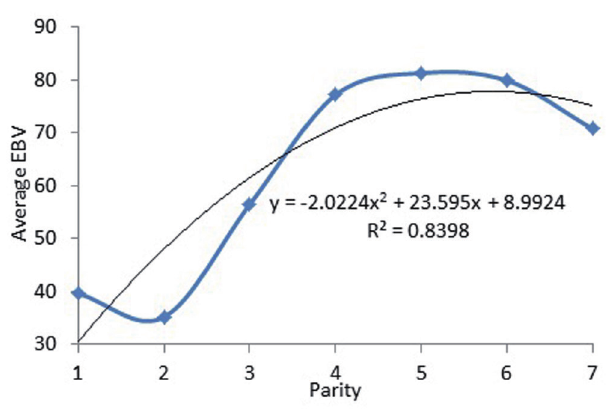
Figure 3. The trend of average estimation of breeding value of dairy cows in different